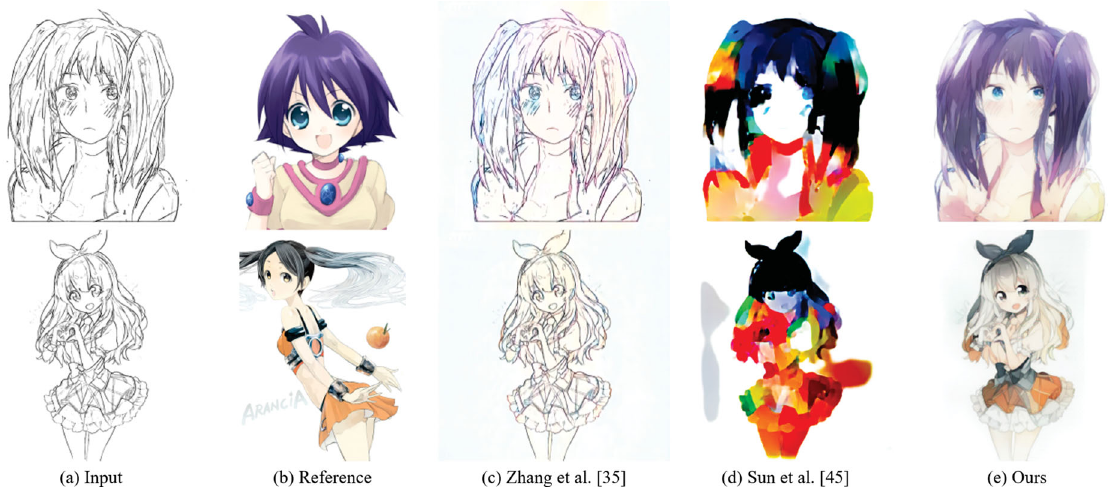
Fig. 7 Comparison of our method to icon colorization and photo colorization